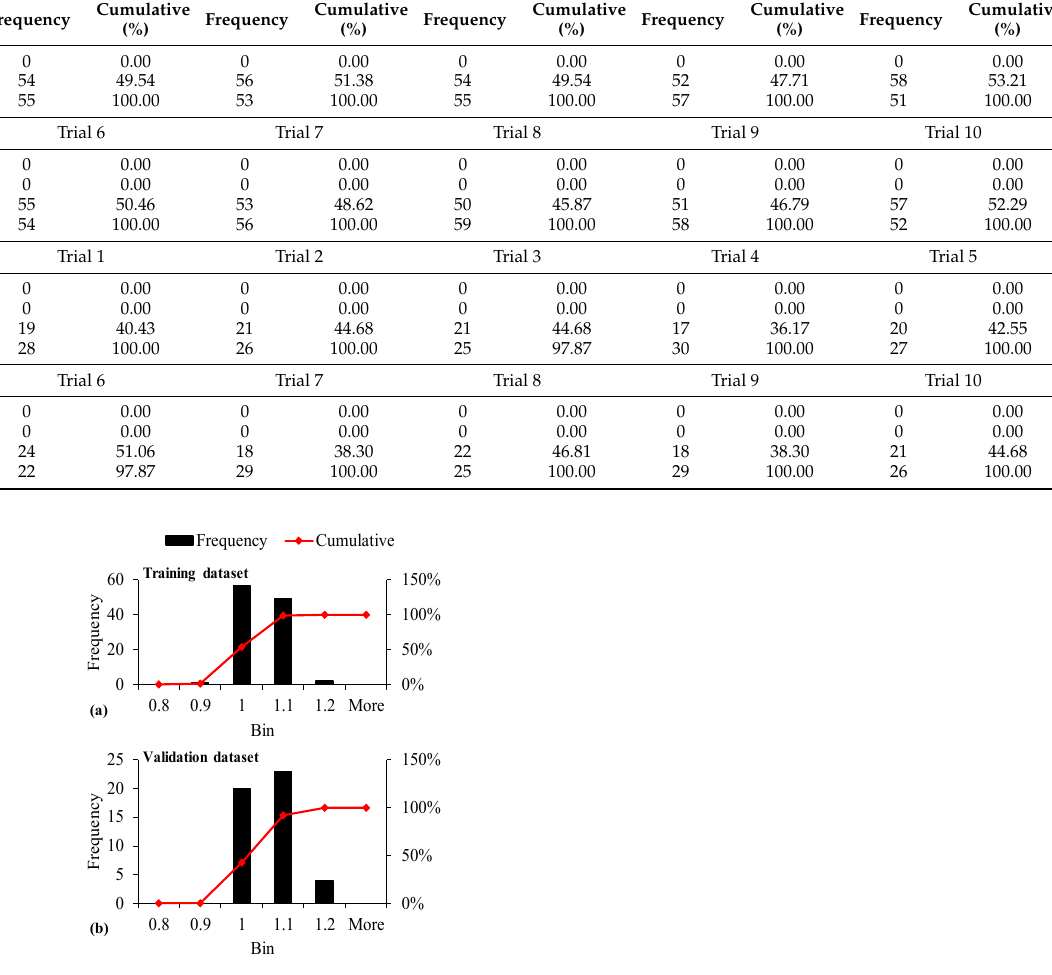
Figure 4. Histogram analysis of predicted to experimental ratios ( ρ ) to determine CS 28 for GEP Trial 5 in case of ( a ) Training dataset, and ( b ) Validation dataset. Table 7. Histogram analysis of predicted to experimental ratios ( ρ ) to determine CS 28 for all the 10 GEP trials undertaken in the current study Dataset Bin Ranges